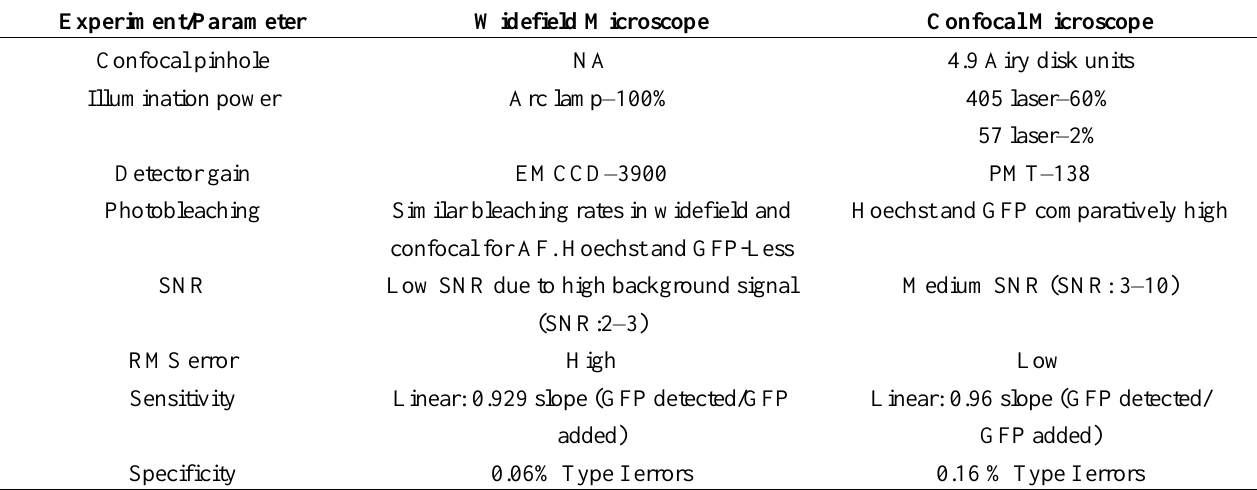
Table 2. Optimal parameters that were determined for detecting green fluorescent protein (GFP) emission in mixed samples with high autofluorescence.